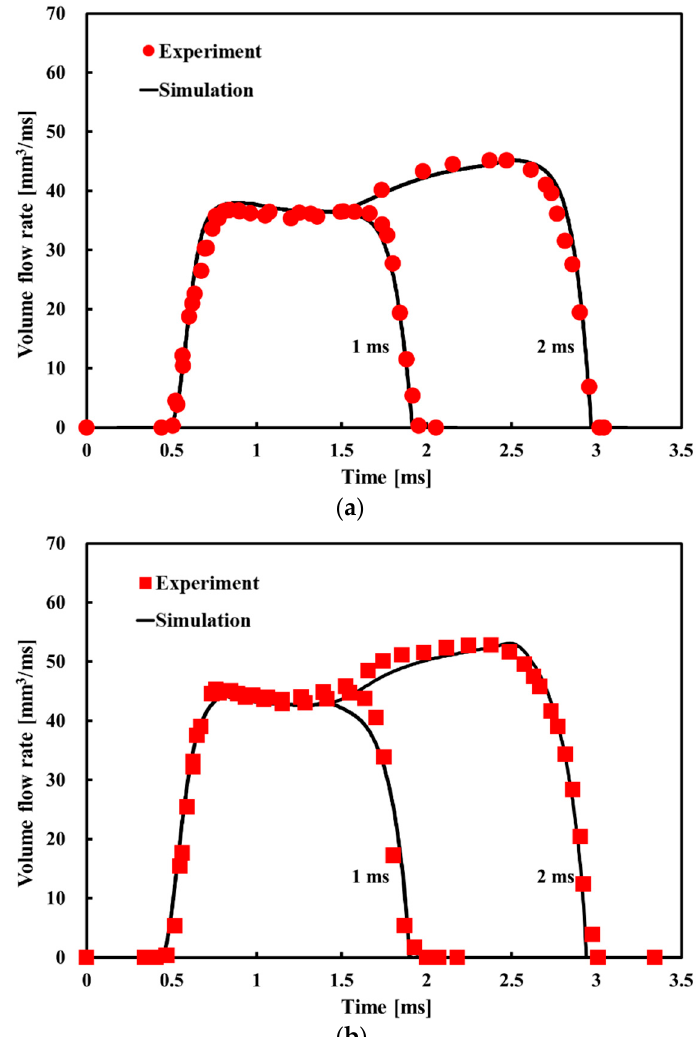
Figure 3. Comparison of the calculation results of isothermal flow model and experimental data under different rail pressures: ( a ) 60 MPa; ( b ) 80 MPa.